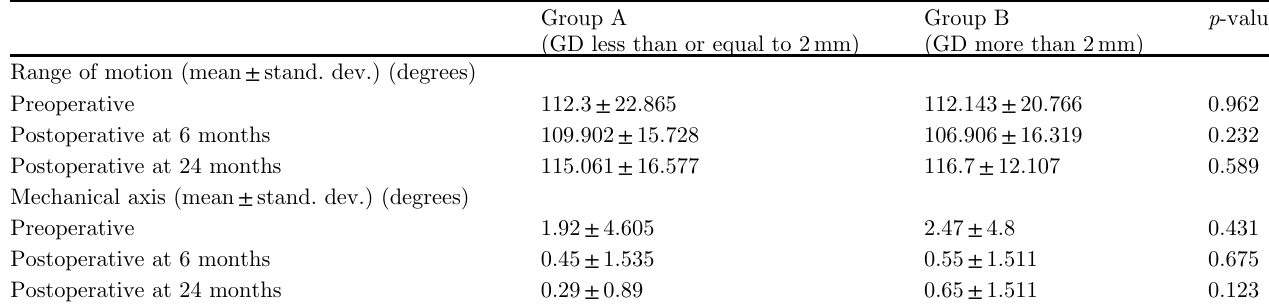
Group A (GD less than or equal to 2 mm)